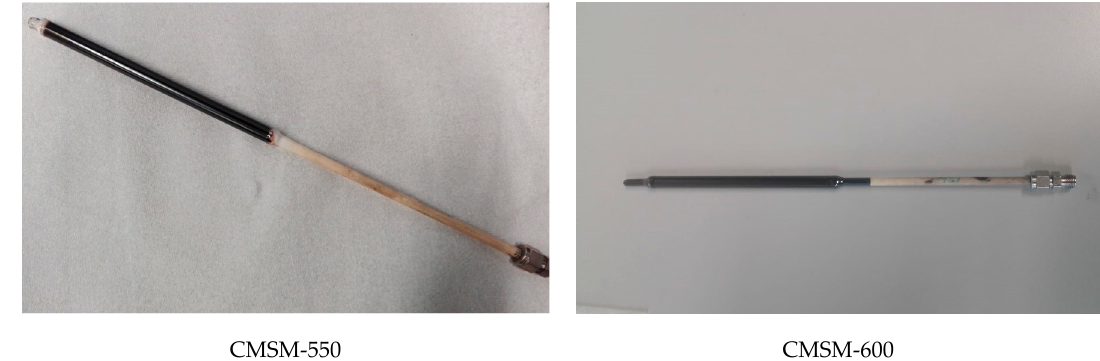
Figure 1. Pictures of the carbon molecular sieve membrane (CMSM)-550 and CMSM-600 carbonized at 550 and 600 °C